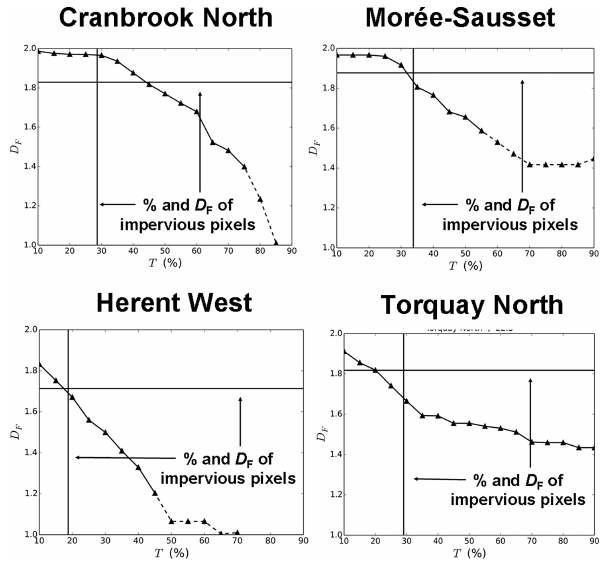
Figure 9. For four study areas: D F vs. T for the map of sub- catchments imperviousness in model is plotted (same as in Fig. 7), fractal dimension from the distributed data (horizontal line), and percentage of impervious pixel at the two metre resolution (vertical